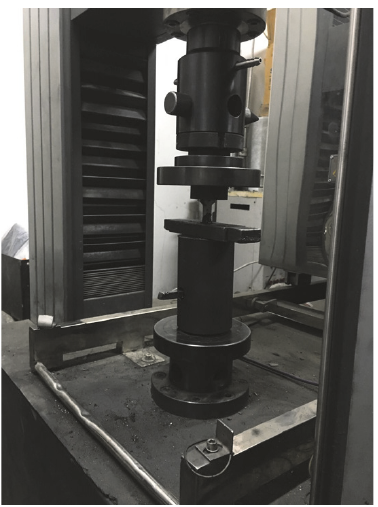
Figure 4: ECAP initial model in SPH method.